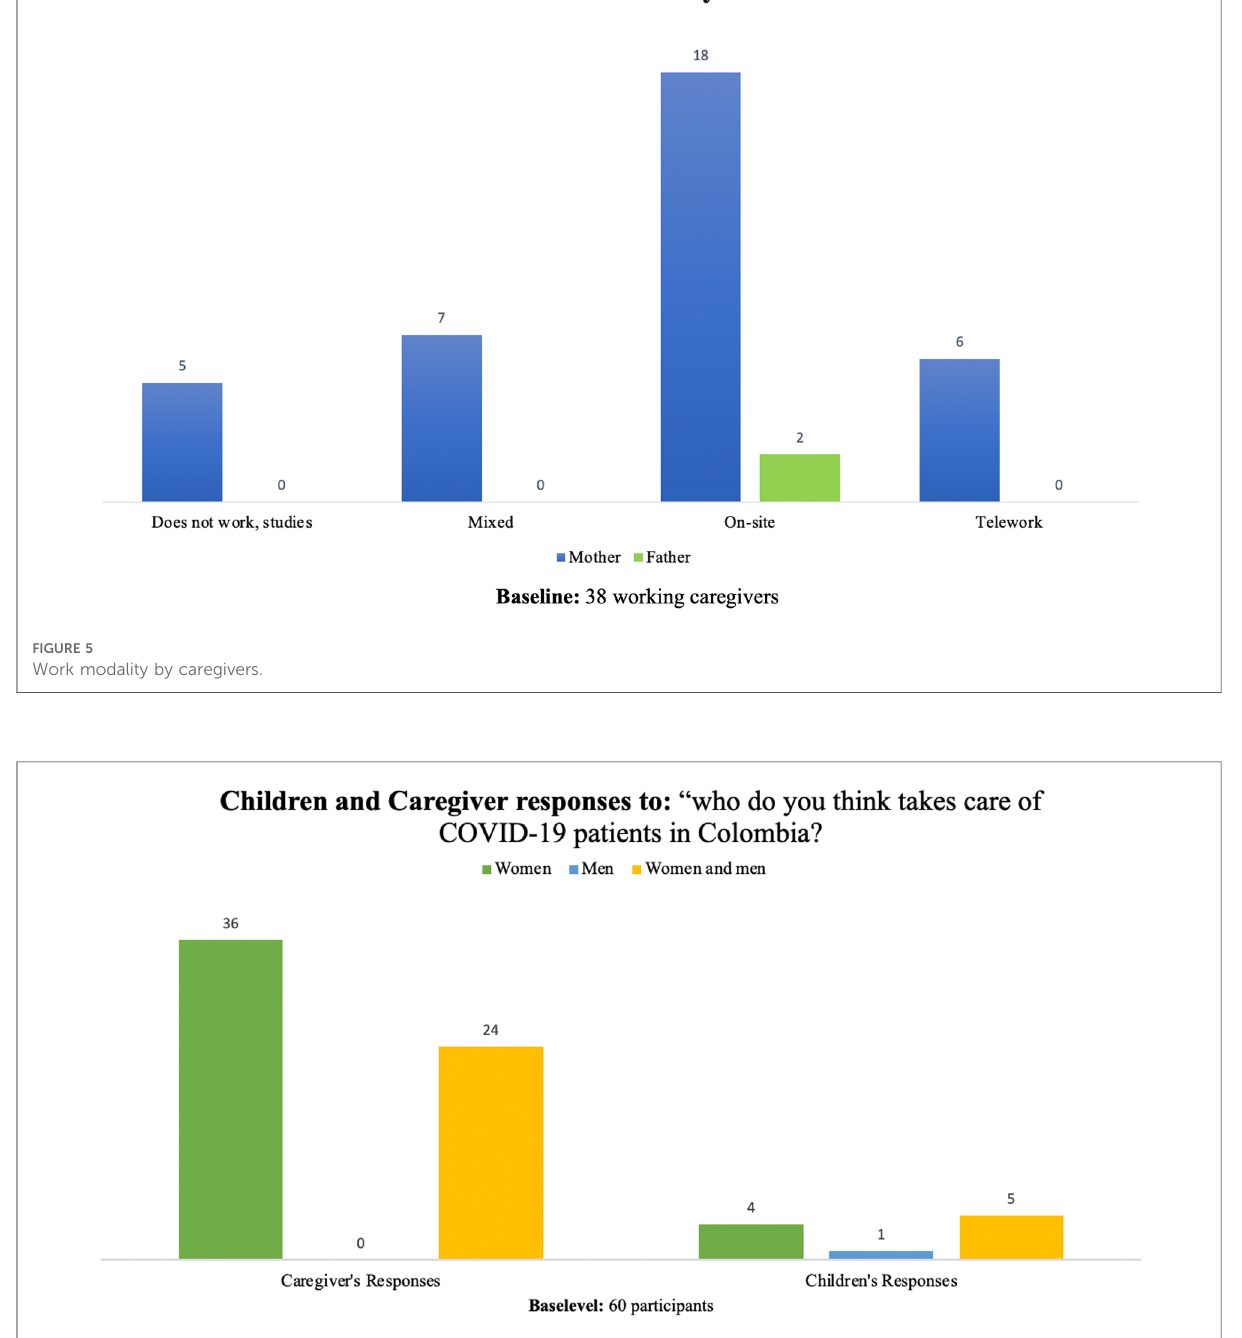
FIGURE 6 Children and caregiver responses to question “ who do you Think Takes Care of COVID-19 Patients Colombia? ”